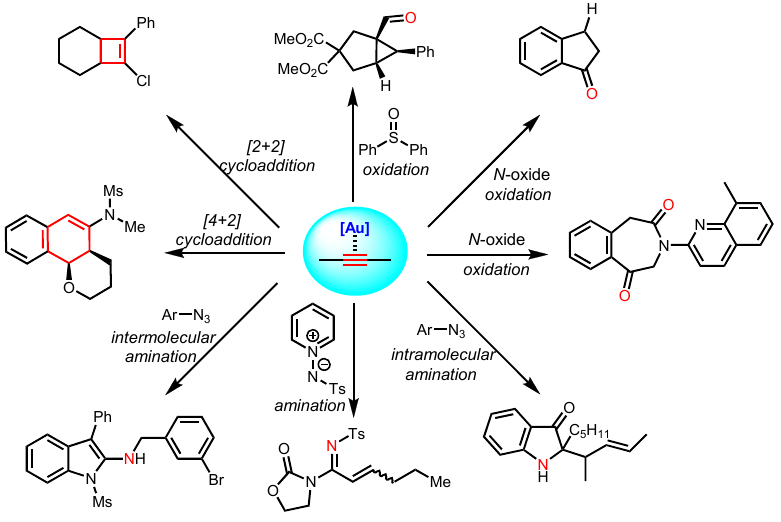
Figure 2. N -heterocyclic carbene gold-catalyzed tandem reactions of alkynes.